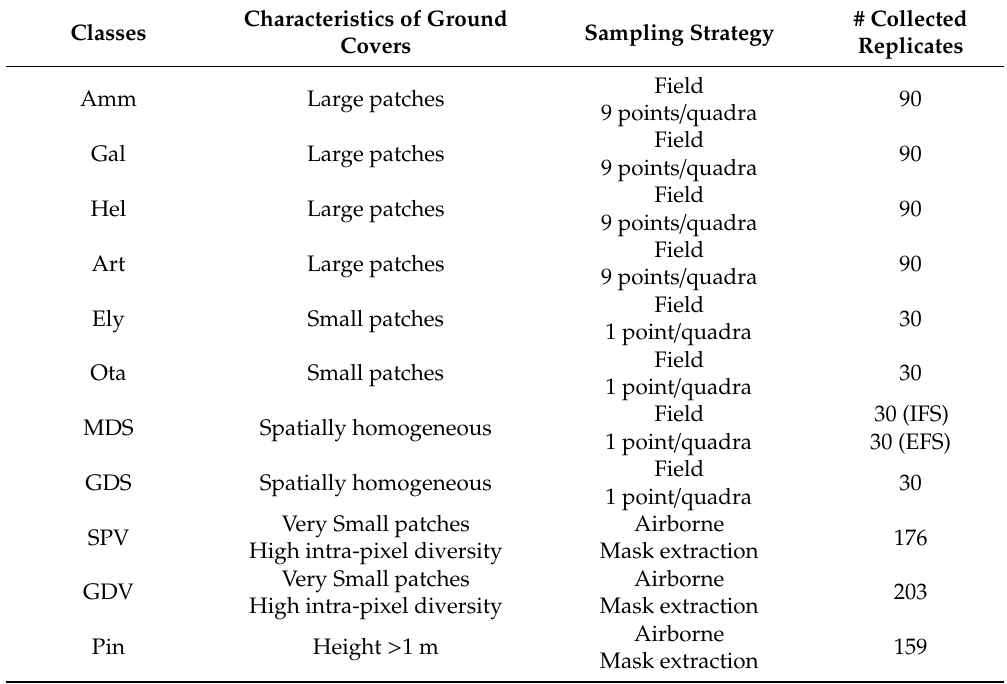
Table 1. Sampling strategies and the number of collected points for the di ff erent plant species and sand types. The choice of the sampling strategy depends on the patch size (large patch ≥ 1 m 2 ; small patch < 1 m 2 ; very small patch << 1 m 2 ), optical homogeneity, and species diversity in a 1 × 1 m 2 pixel. List of acronyms: Amm ( Ammophila arenaria ), Gal ( Galium arenarium ), Hel ( Helychrisum stoechas ), Art ( Artemisia campestris ), Ely ( Elymus farctus ), Ota ( Otanthus maritimus ), MDS (Mobile Dune Sand), GDS (Grey